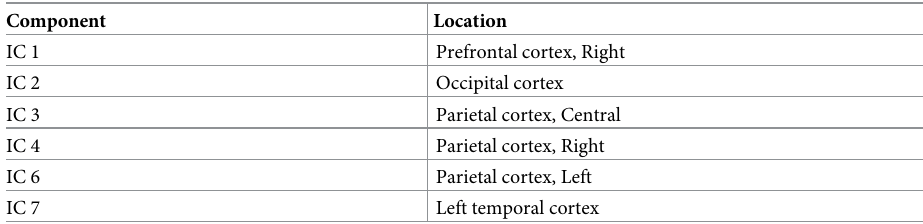
Table 4. Source locations of the independent